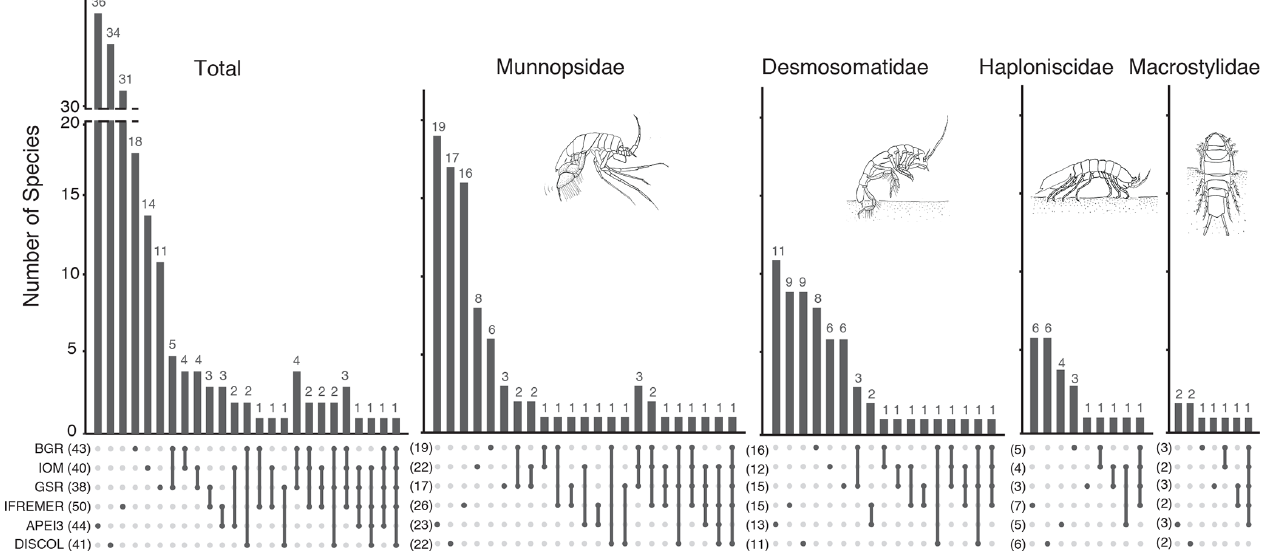
Figure 12. UpSet plot showing the number of species shared between sampling sites. The lower panel shows the sets of combination of sites. Sites sharing species are indicated by dots joined by a vertical line. The corresponding bar in the upper panel shows the number species co-occurring in this particular set of stations. Table 4. Number and percentage of species of the studied families present in only one to six areas. “Total” considers all areas together. One area Two areas Three areas Four areas Five areas Six areas